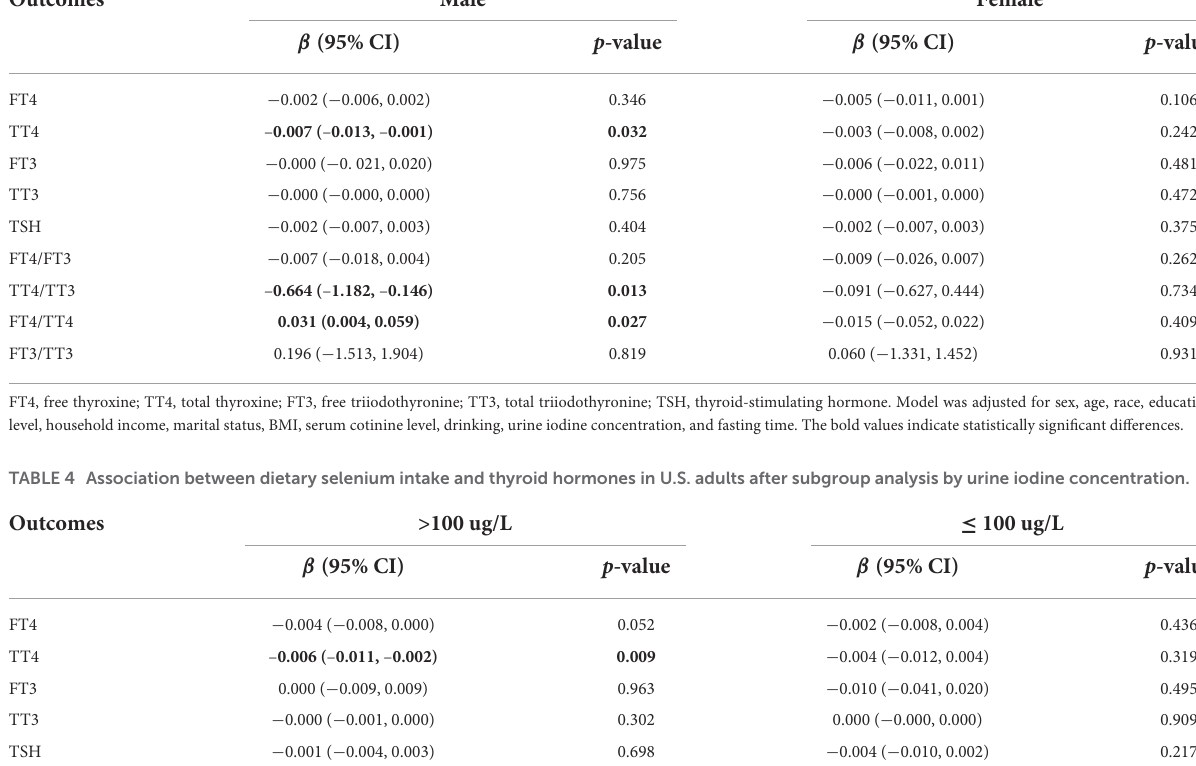
TABLE 3 Association between dietary selenium intake and thyroid hormones in U.S. adults after subgroup analysis by sex. Outcomes